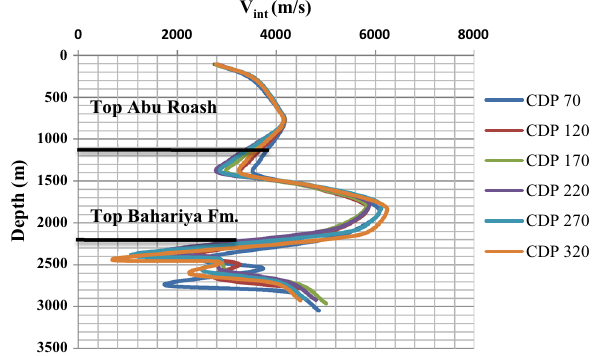
Fig. 10 Interval velocity for 6 CDPs along inline